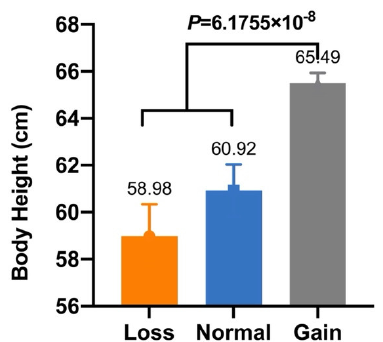
Figure 2. Association analysis between CNV1 and body height in SBWC goats.